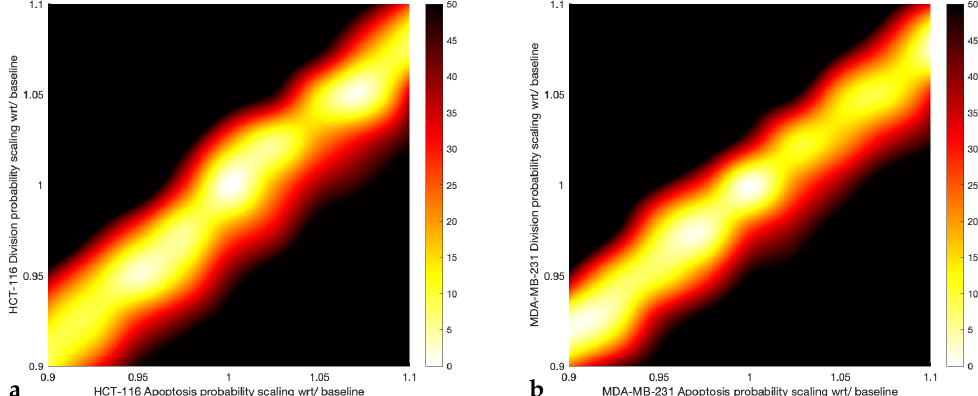
Figure 5. Heat-maps of the absolute error of the simulation results for ( a ) the HCT-116 and ( b ) MDA- MB-231 cell line, respectively, under control conditions. Horizontal and vertical axes describe the scaling of P apoptose and P divide , respectively. The colour-bar represents the percentage of absolute error with black areas corresponding to ≥